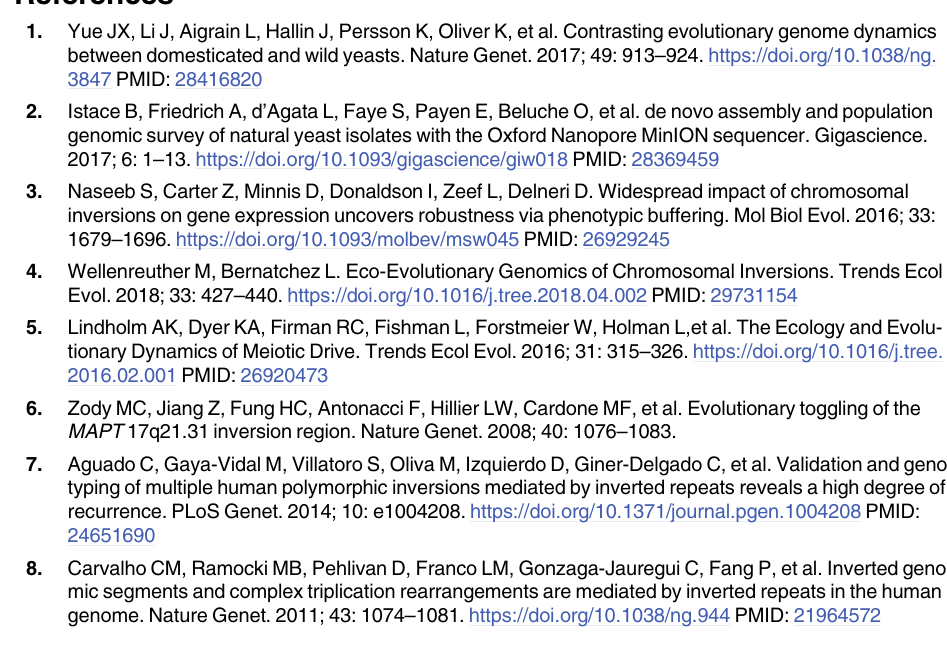
S1 Data. Flow cytometry numerical data for Fig